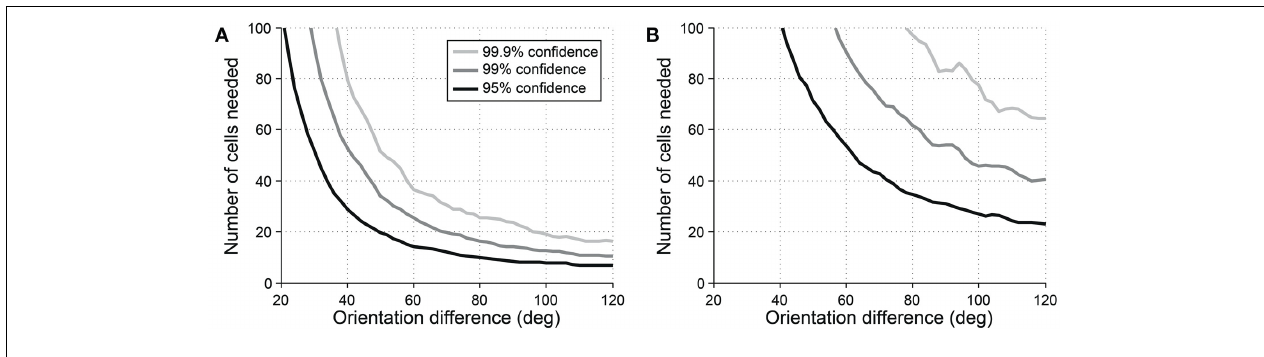
FIGURE 10 | Sensitivity of the 2-sample version of Hotelling’s T-squared test for detecting differences preferred orientation between different cell populations. Cells were simulated with seven trials each. We systematically varied the size of the cell populations and the size of the difference in preferred orientation.